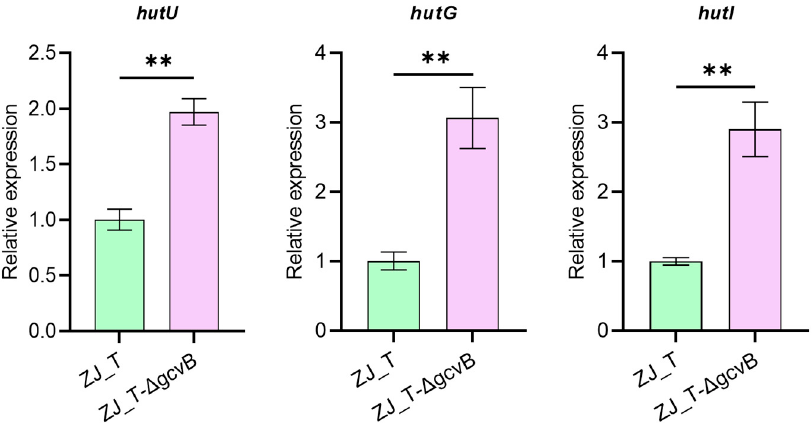
Figure 9. Relative expression of genes involved in the histidine metabolism pathway by qRT-PCR (Student ’s t -test, p value: **, <0.01). The levels of gcvB were normalized to the internal control 16S rRNA level. Error bars indicate standard